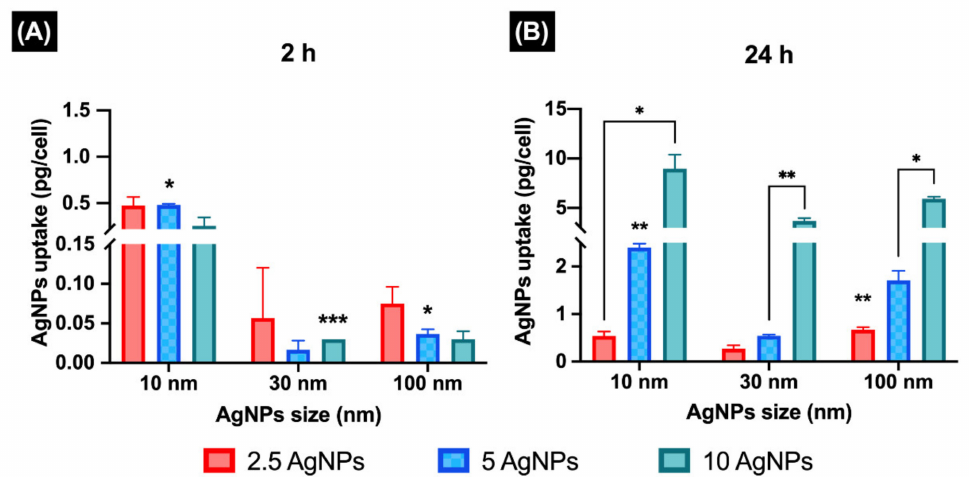
Figure 3. Intracellular uptake of AgNPs. ZF4 cells were treated with 2.5, 5, and 10 µ g/mL of three different AgNP sizes (10, 30, and 100 nm) for 2 and 24 h. The total uptake of AgNPs (as Ag + ) was assessed by ICP–MS. ( A ) Total intracellular Ag + for each concentration and AgNP size after 2 h of exposure. ( B ) Total intracellular Ag + after 24 h. Mass results ( µ g/mL) obtained by ICP–MS were normalised to total Ag + /cell in an equal number of 100,000 cells and then transformed to pg/cell for simpler representation. Three individual replicates were performed for each AgNP concentration, size, and timepoint. Data with asterisks (*) indicate statistical differences (* p < 0.05, ** p < 0.01, and *** p < 0.001) for the NP treatments compared to the untreated cells (naive), whose values (zero) were not included in the